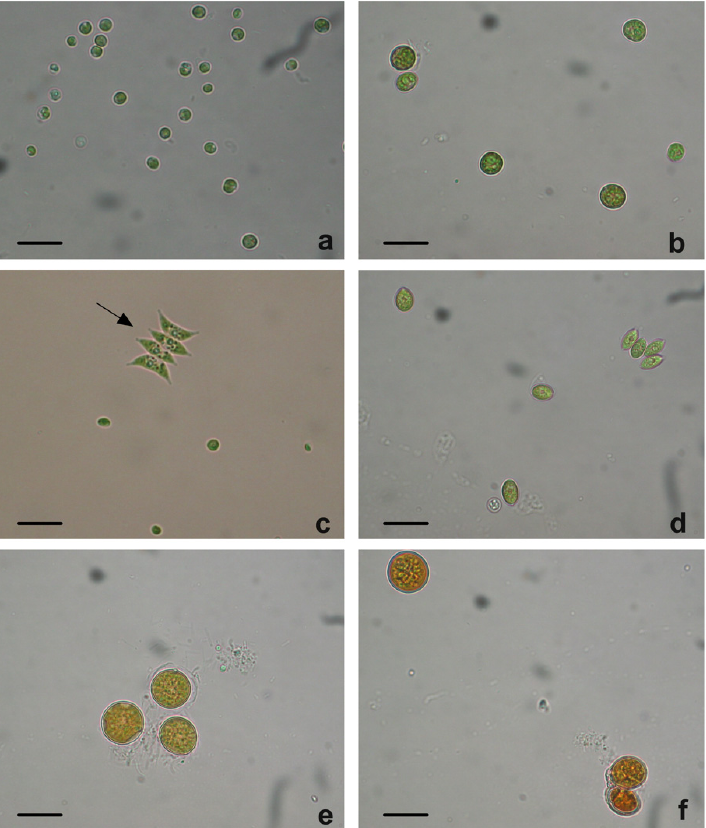
Figure 1. Light microscope images of the most representative microalgal strains collected from the urban wastewater (UWW) stream deriving from the dewatering process of digested sludges (=centrate). Images refer to: ( a ) roundish green cells identified as Chlorella sp.; ( b ) isolated strain characterized by larger roundish green cells (cell diameter of about 10–15 µ m); ( c ) mixed culture showing small green roundish cells and a typical colony of Scenedesmus sp. algae (arrow); ( d ) strain of microalgae identified as Scenedesmus sp.; ( e , f ) microalgal isolates characterized by large (20 µ m) greenish to orange cells. Bars: 25 µ